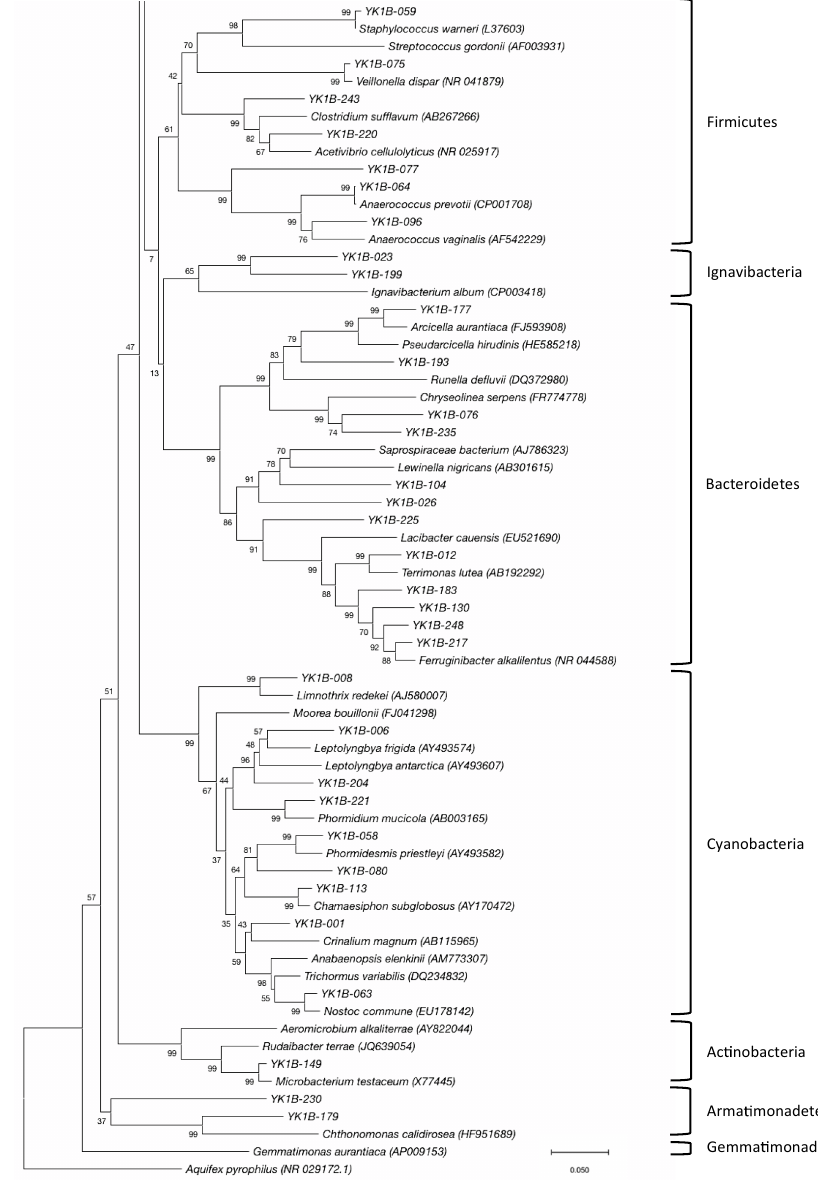
Figure 7. Phylogenetic tree of Firmicutes, Ignavibacteria, Bacteroidetes, Cyanobacteria, Actinobacteria and Armatimonadetea clones. The DNA database accession numbers for described species are in parentheses. The bar indicates evolutionally distance. The bootstrap value of each node is indicated.